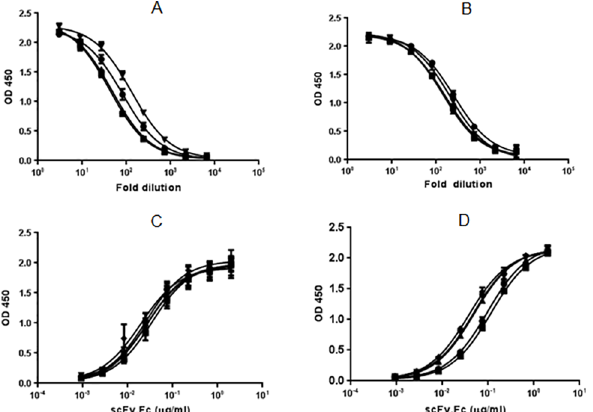
Fig 5. Antigen binding activity of scFv.Fc of clones 1 and 2 expressed from different pSplice vectors in bacteria (A and B, respectively) and in 293F cells (C and D, respectively). The symbols represent the following: circle-pSplice v.2; square- pSplice v.3; triangle- pSplice v.4; inverted triangle- pSplice v.5 and diamond- pOEscFv.Fc (only for mammalian expression in C and D). The scFv.Fc proteins did not bind to